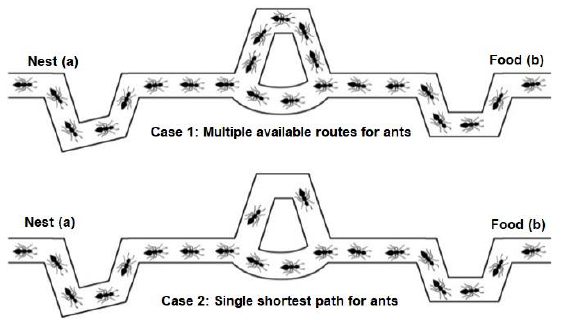
Figure 2. Food hunting procedure in Ant system, case 1 presents the multiple routes while Case 1 shows only single shortest route available for ants. shows only single shortest route available for